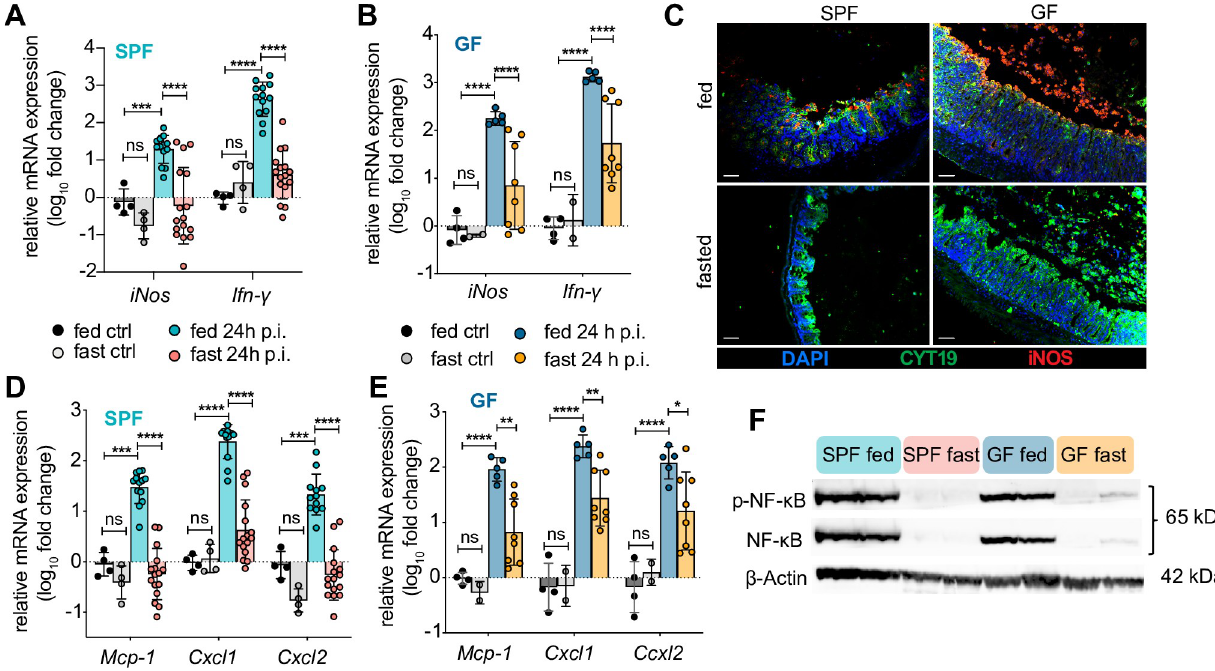
Fig 5. Fasting suppresses mucosal NF- κ B expression and downstream inflammatory mediators. (A-B, D-E) qPCR analysis of iNos and Ifn- γ mRNA expression in SPF (A) and GF (B) and different chemoattractants in SPF (D) and GF (E) S . Typhimurium-infected mouse ceca, expressed as fold change over fed ctrl. Fed ctrl and fast ctrl refer to uninfected ad libitum fed or 48h fasted C57BL/6 GF or SPF mice. (C) Representative immunofluorescence staining of inducible nitric oxide synthase (iNOS) and IEC on SPF and GF cecal sections at 24h p.i. with S . Typhimurium ± 48h of fasting, n = 6. Sections were stained using DAPI to detect DNA (blue), anti-iNOS (iNOS, red) to visualize iNOS expression and anti-cytokeratin 19 (CYT19, green) to stain IEC. Scale bar 50 μ m. (F) Representative immunoblot detecting phosphorylated and total NF- κ B p65/RelA protein in whole cecal tissue lysates of SPF and GF mice at 24h p.i. with S. Typhimurium ± 48h of fasting. Lanes represent data from individual mice, n � 5. Equal loading confirmed with β -actin as well as total protein stain of membrane (see S5 Fig). All data shown repeated in at least 3 independent experiments. For (A, B, D, E) data from multiple independent experiments were pooled. ���� p < 0.0001, ��� p < 0.001, �� p < 0.01, � p < 0.05, ns = not significant. Significance levels calculated by two- way ANOVA with Tukey post test. Error bars shown as ± SD. Related to S5 Fig.